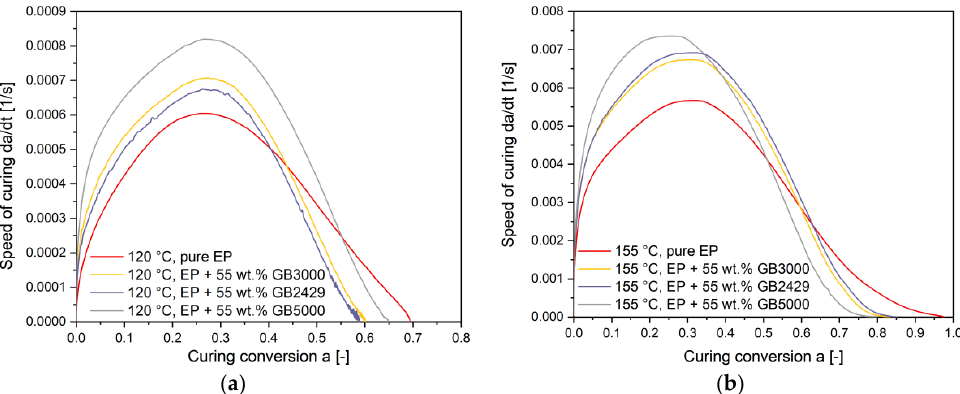
Figure 14. Curing speed versus curing conversion for compounds with different filler size at ( a ) 120 ◦ C and ( b ) 155 ◦ C.